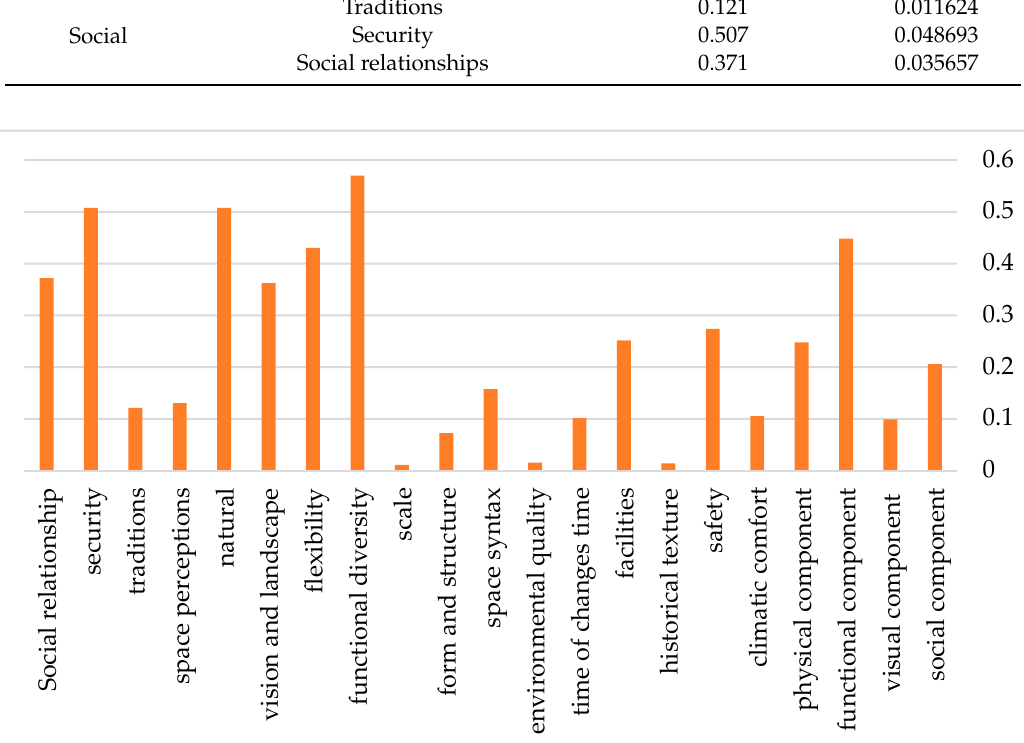
Figure 8. Criteria and sub-criteria weight .